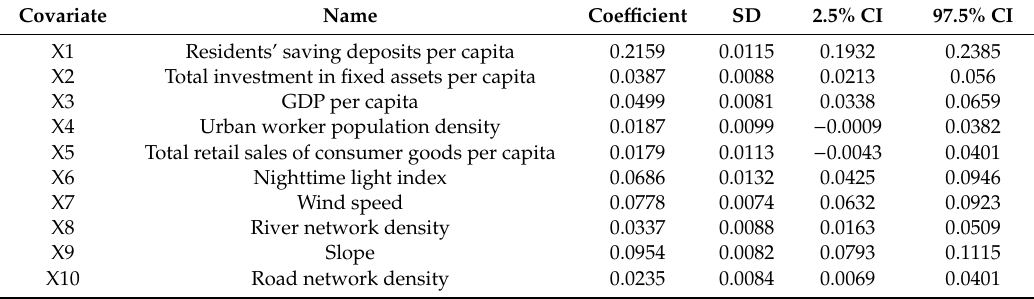
Table 3. Global-scale regression statistics of socioeconomic and environmental covariates a ff ecting healthcare resources of hospital beds over southwest